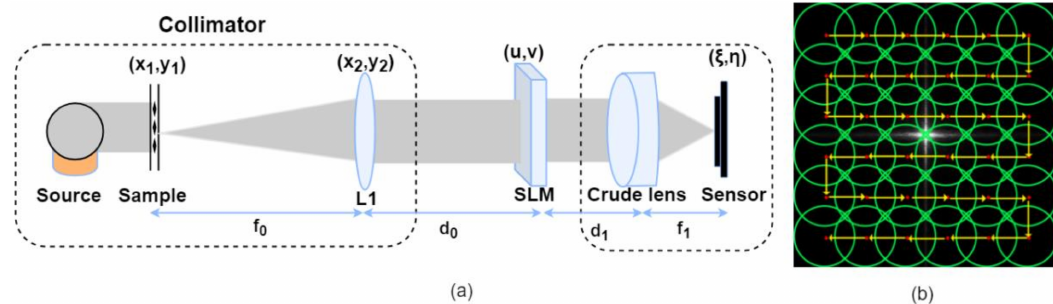
Figure 1. ( a ) The experimental setup schematic. ( b ) The sub-aperture M ( u , v ) loaded on the SLM. Green circles indicate the coverage of each sub-aperture. Red dots indicate the center position of the sub-aperture. Yellow arrows indicate each movement of the